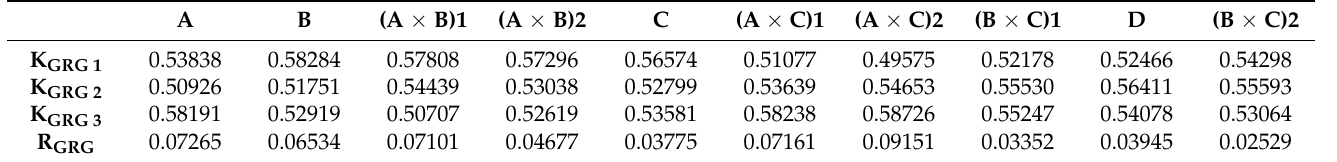
Table 12. Range analysis for GRG.